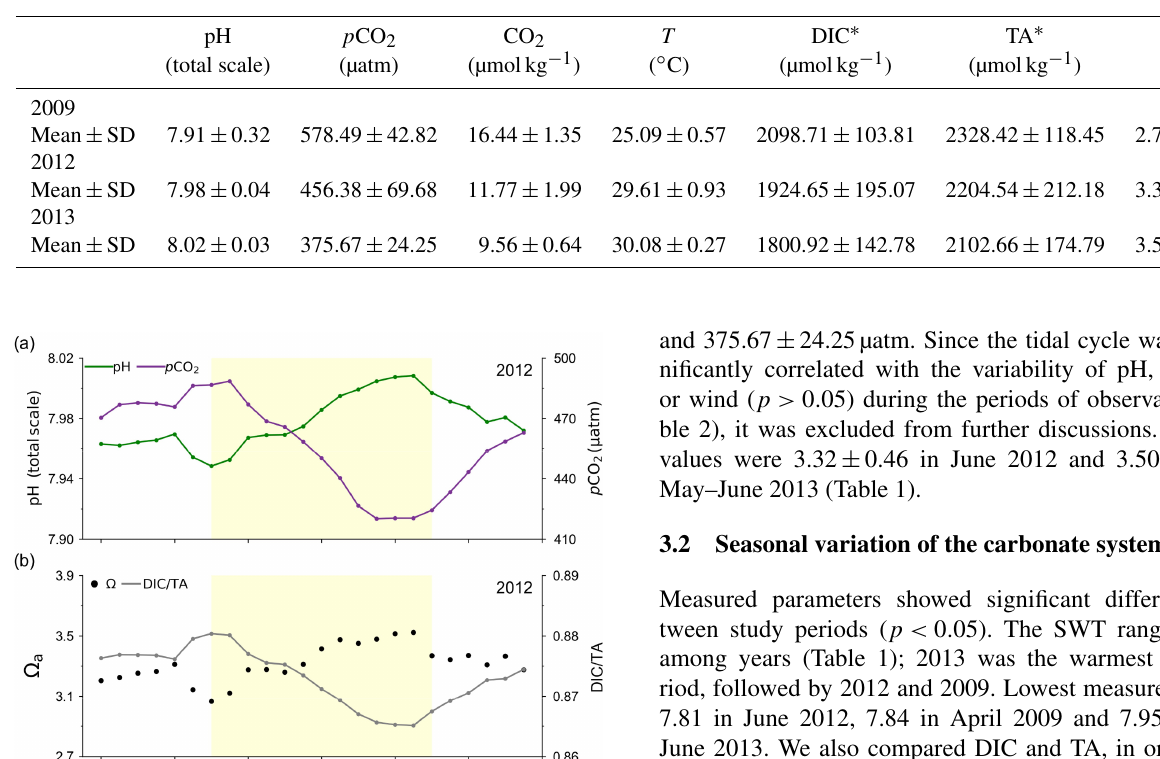
Table 1. Measured and calculated ( ∗ ) parameters, during upwelling (2009) and non-upwelling seasons (2012, 2013) at Bahía Culebra, Costa Rica.